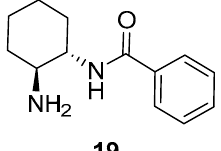
Figure 3. The OH-free organocatalyst employed in this study.